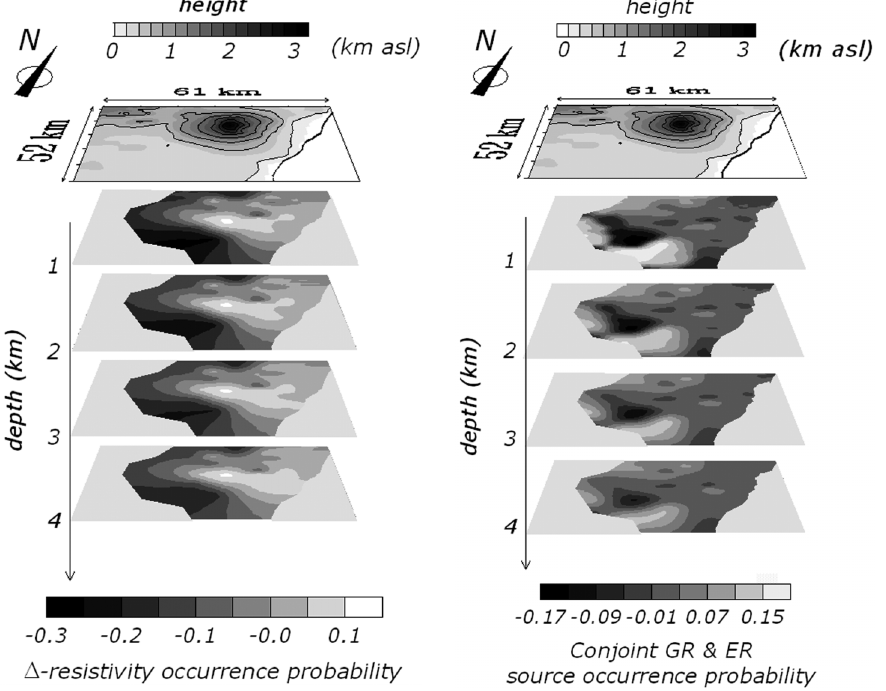
Fig. 13. The Mt. Etna case-history. The resistivity source probability tomography. The top slice is the reference topographic map. The following tomographic column refers to the depth range from 0.5 km a.s.l. to 4 km b.s.l. with a slicing step of 0.5 km. Fig. 14. The Mt. Etna case-history. The integrated gravity and resistivity source probability tomography. The top slice is the reference topographic map. The following tomographic column refers to the depth range from 1 km b.s.l. to 4 km b.s.l. with a slicing step of 1